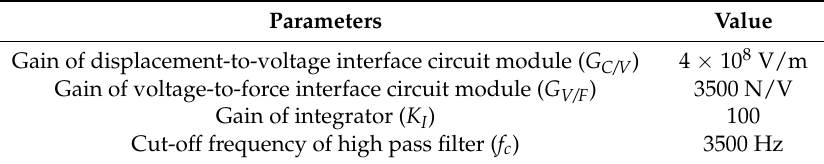
Table 2. Parameters of the closed-loop